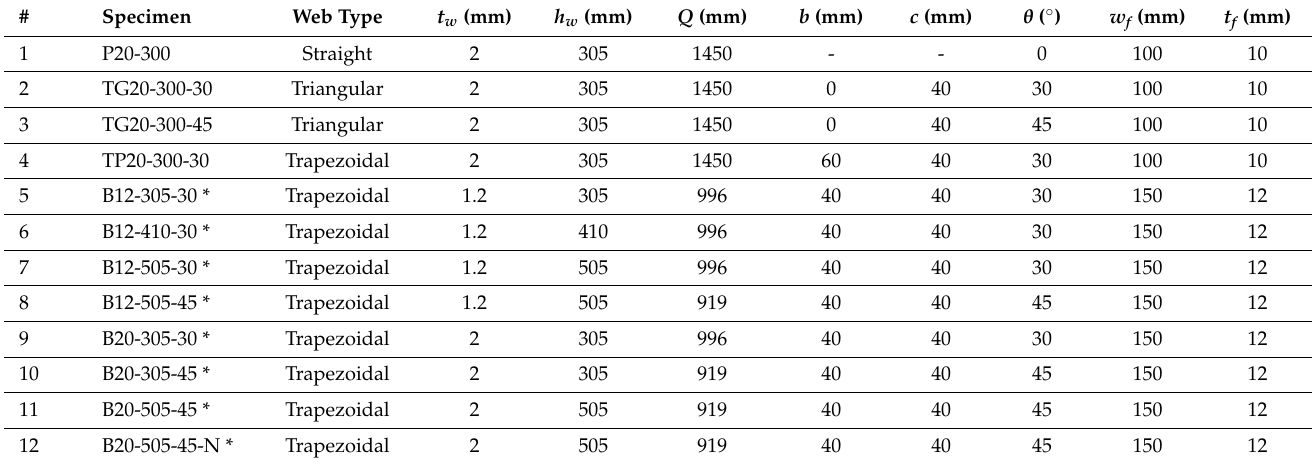
Table 1. The geometry of beam